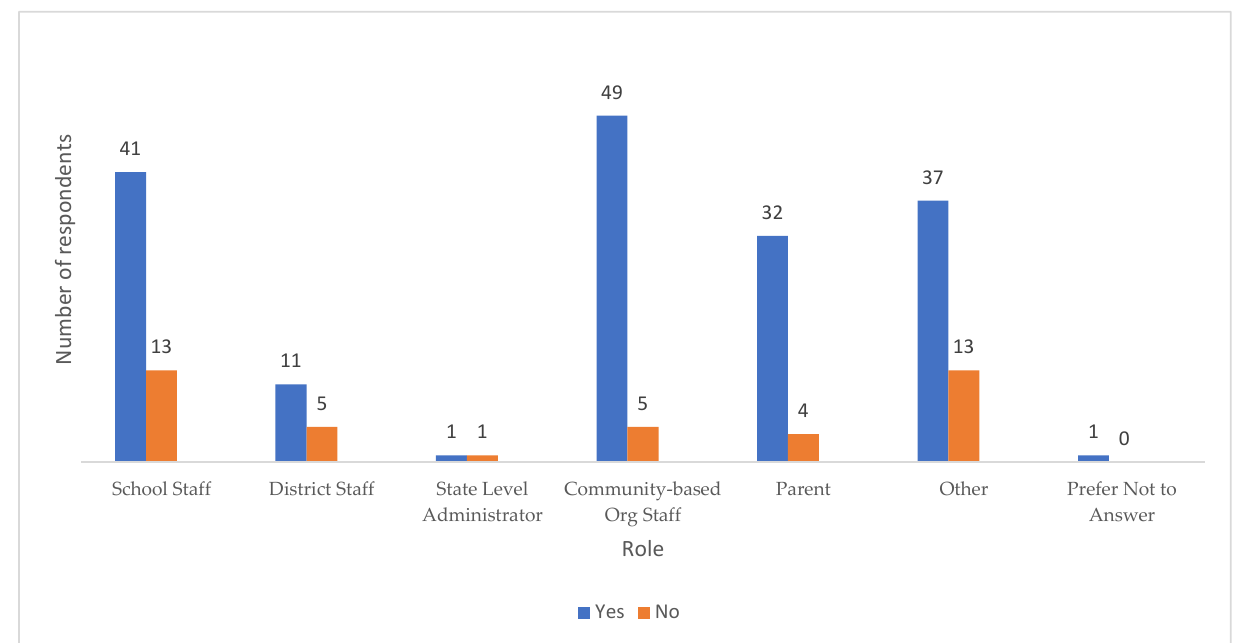
Figure 2. Respondents reporting increased awareness of family engagement services.